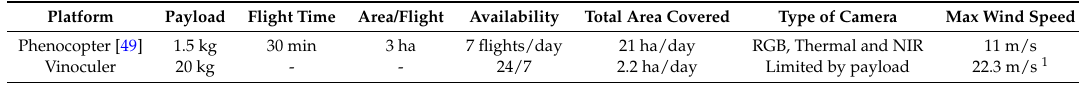
Table 2. Comparison between Vinoculer and the UAV-based phenotyping system presented in [49]. Platform